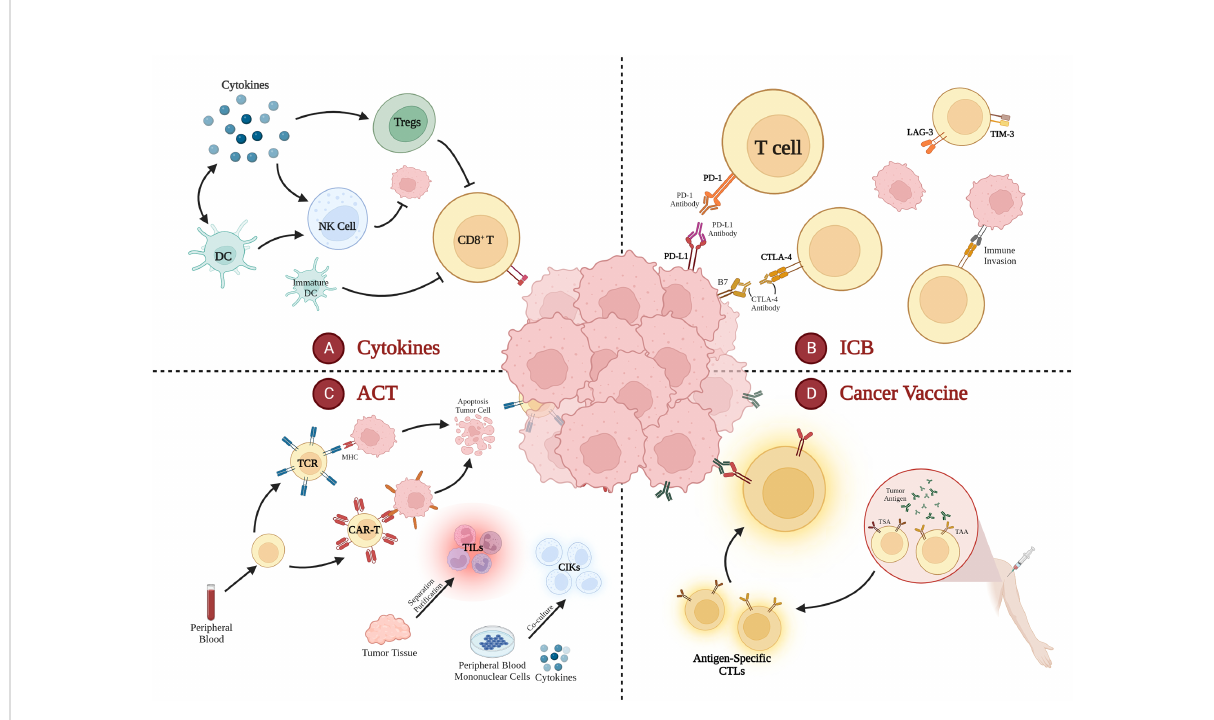
FIGURE 2 Applications of Immunotherapy in Cold